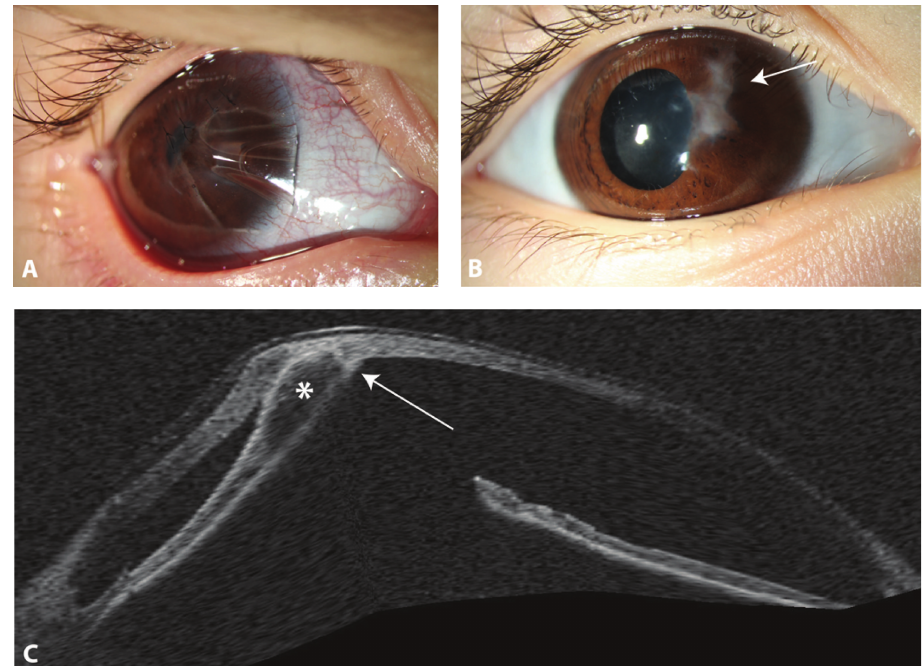
Figure 2: Spontaneous corneal perforation in a child with brittle cornea syndrome. (A) For primary repair of the spontaneous corneal rupture of the right eye 4 corneal sutures were placed and the right eye was covered with a contact lens. (B) After suture removal, cornea healed and mild iris incarceration (arrow) persisted. (C) Optical coherence tomography (OCT) showed the iris incarceration ( asterisk ∗ ) to be only adherent on the rear surface of the cornea (arrow). Corneal thickness was 289 𝜇 m.